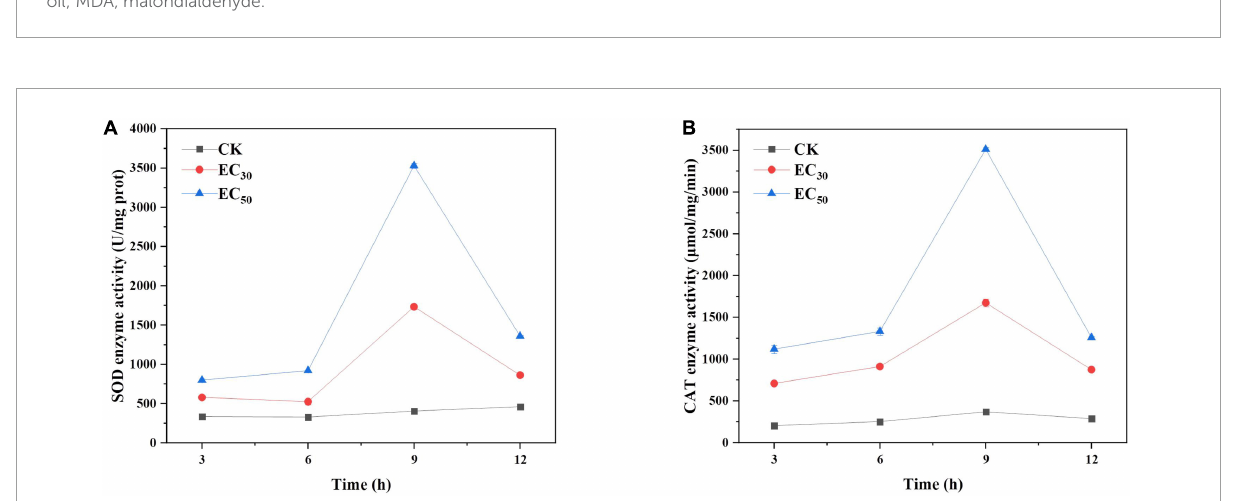
FIGURE6 Effects of JEO on the activities of CAT (A) and SOD (B) secreted from B. cinerea mycelia during 12 h of incubation. B. cinerea was treated with different concentrations of JEO (0 as control, EC 30 , and EC 50 ). The bars represent the standard error of the mean ( n = 3). CAT, catalase; JEO, juniper essential oil; SOD, superoxide dismutase.